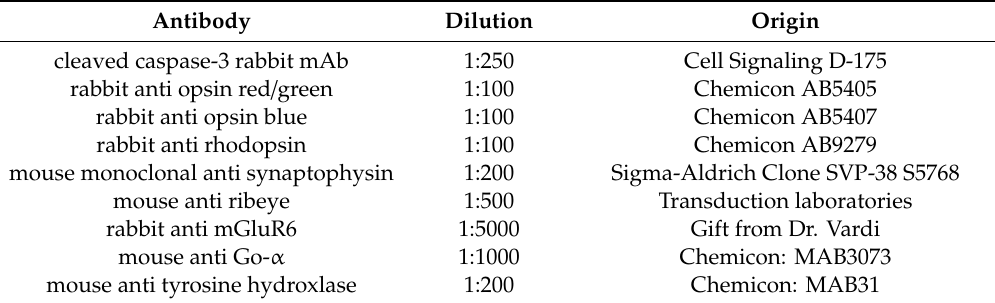
Table 2. Primary antibody